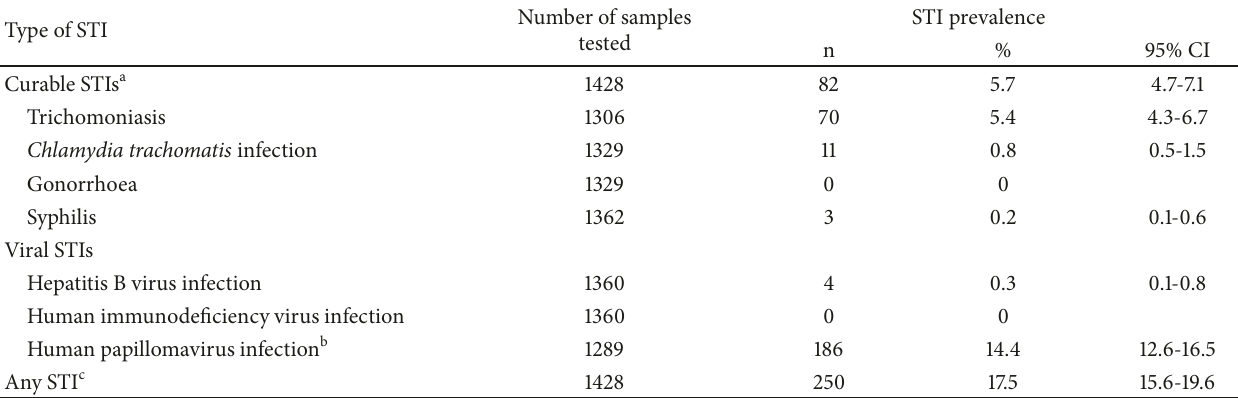
Number of samples STI prevalence tested n % 95% CI